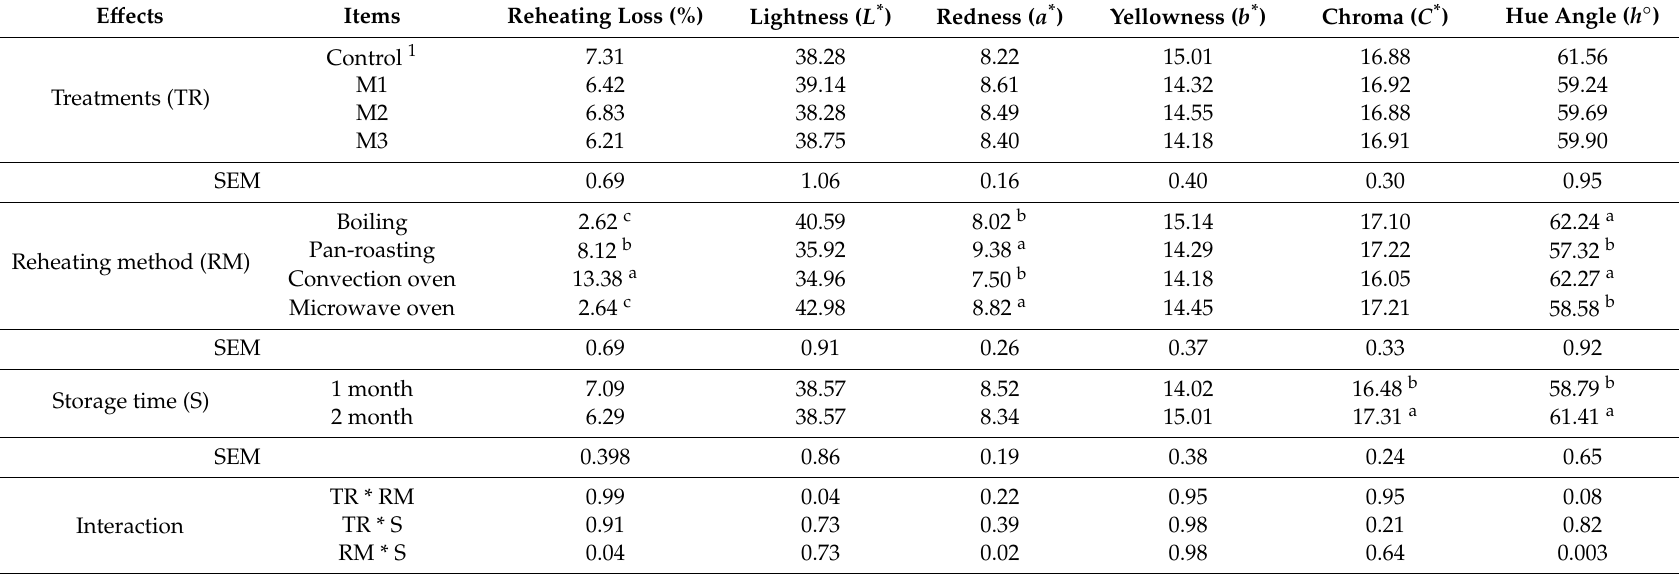
Table 3. E ff ect of di ff erent reheating condition on reheating loss and color parameters of nutmeg-extract-added beef meatballs during frozen storage. E ff